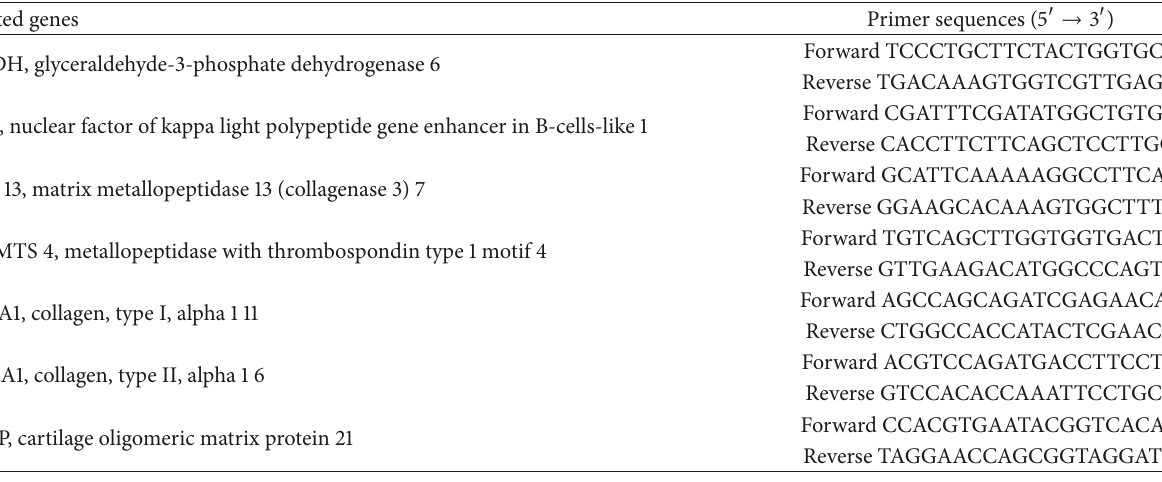
Table 1: Genes and primer sequences used in the